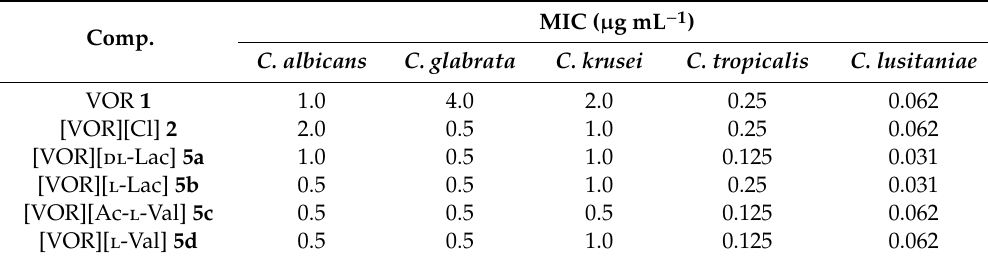
Table 2. Fungistatic activity of VOR and its salts against selected Candida reference strains. MICs were determined by the microtiter serial twofold dilution method in RPMI-1640 medium.